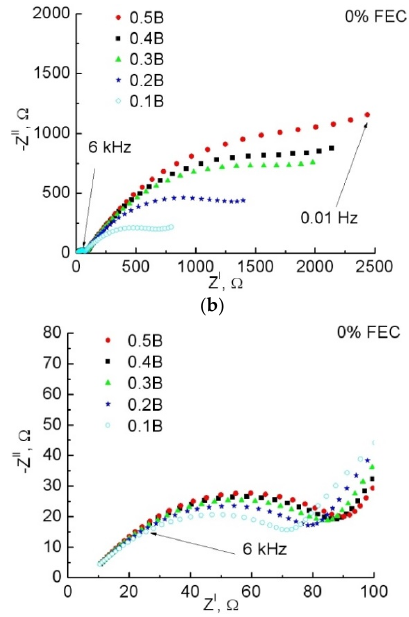
Figure 8. General view ( a , b ) and high ‐ frequency region ( c , d ) of impedance hodographs at different